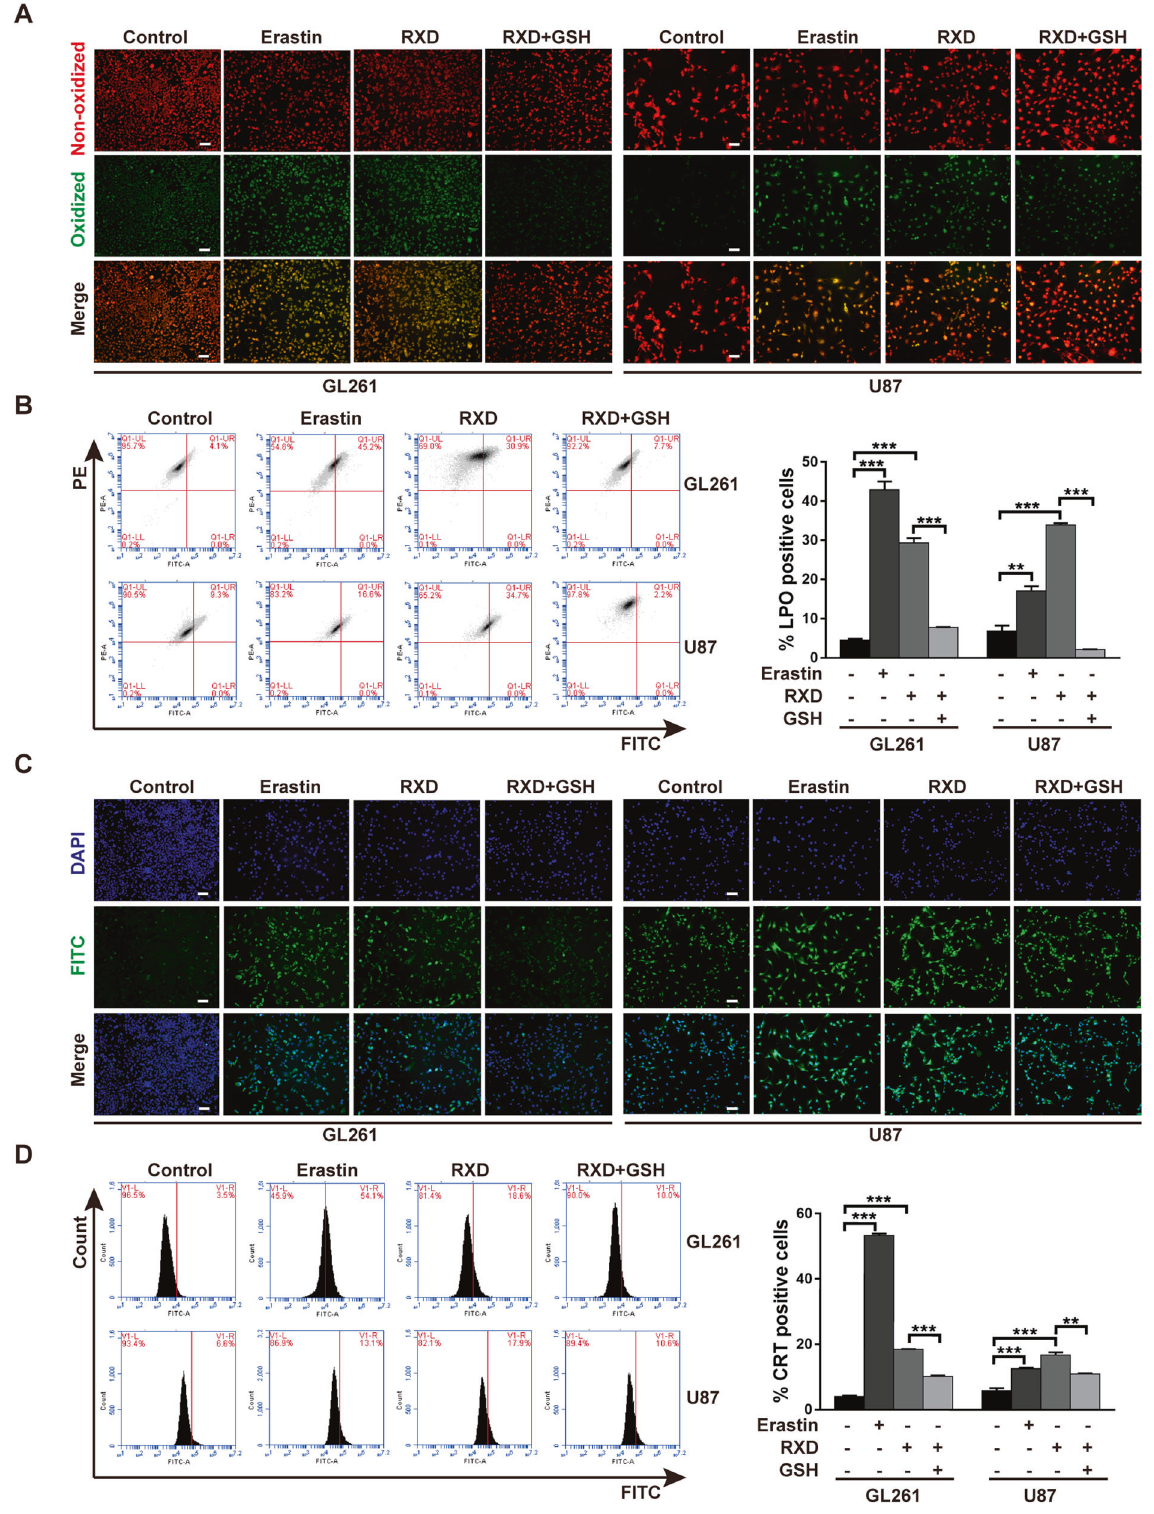
Fig. 3 Roxadustat increased lipid peroxidation and calreticulin exposure. A Representative fl uorescent images of lipid peroxidation in GL261 or U87 cells after incubation with Erastin (10 μ M) or RXD (100 μ M towards U87, 200 μ M towards GL261) with or without GSH (500 μ M) for 48 h. Scale bar: 100 μ m. B Representative fl ow cytometry analysis and statistical histogram of LPO-positive cells in GL261 or U87 cells with the different treatments. C Representative fl uorescent images of CRT in GL261 or U87 cells after the different treatments. Scale bar: 100 μ m. D Representative fl ow cytometry analysis and statistical histogram of CRT-positive cells in GL261 or U87 cells after the different treatments. * P < 0.05, ** P < 0.01, *** P <